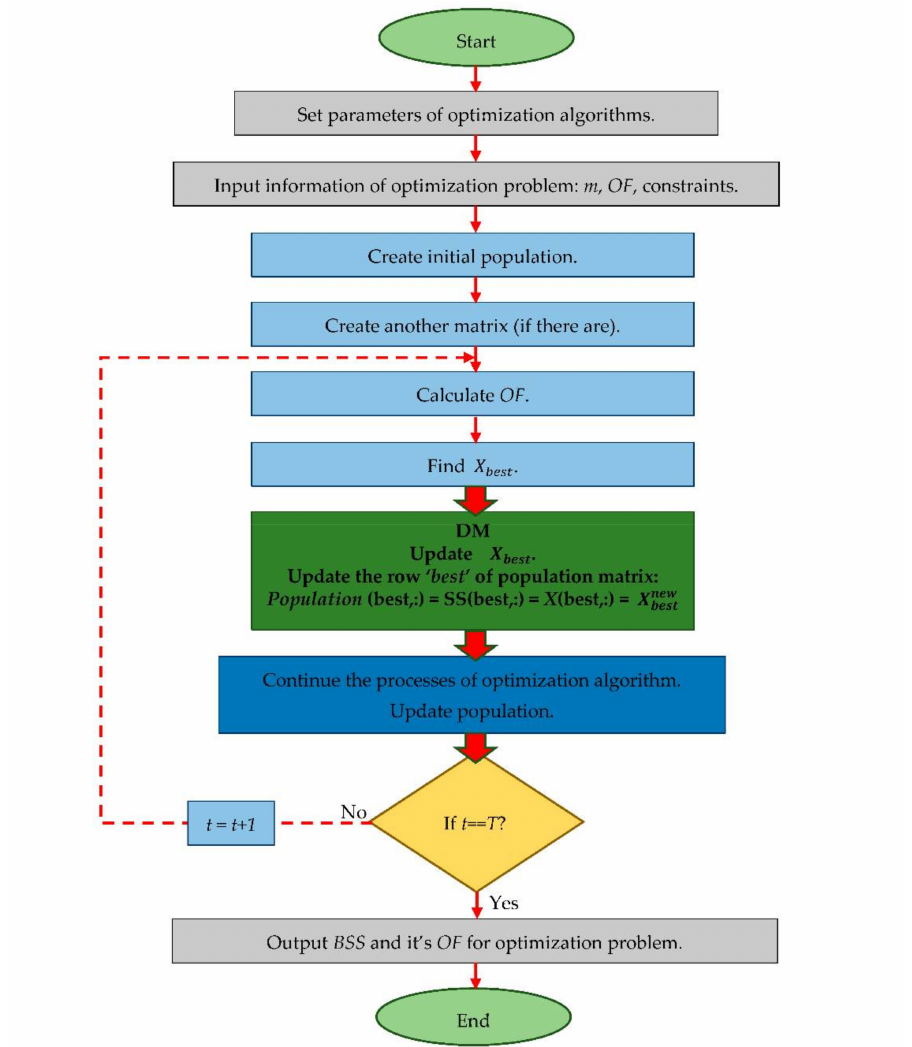
Figure 2. Flowchart of implantation of the DM for modifying optimization